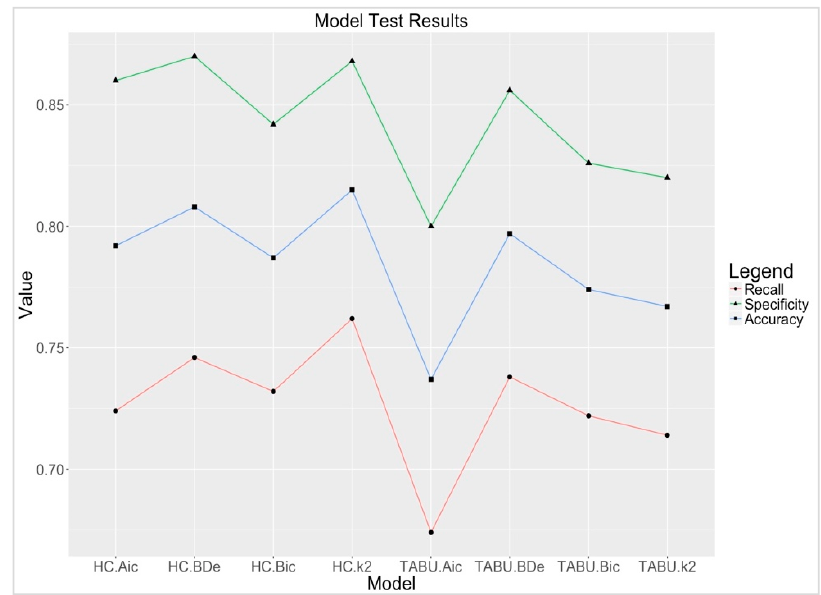
Figure 10. The results of the model testing.